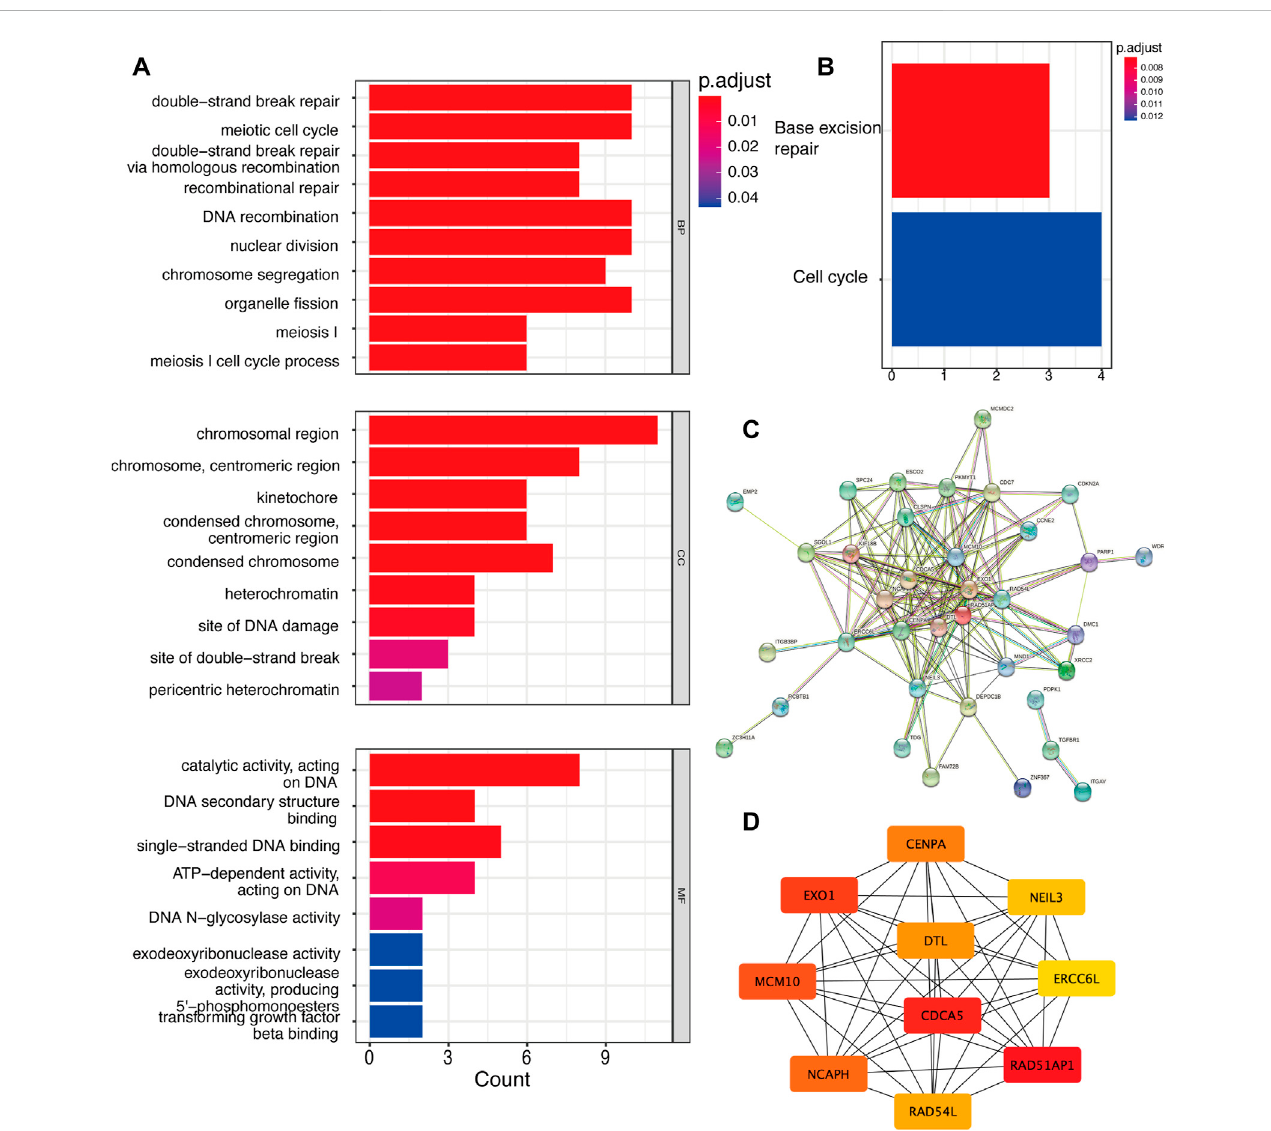
FIGURE 2 The down-regulated DEGs regulatory network and gene functions. (A) . GO analysis of down-regulated DEGs. (B) . KEGG analysis of DEGs. (C) . The PPI network of DEGs. (D) . Top 10 hub genes of down-regulated genes. DEG: differentially expressed genes, PPI: protein-protein interaction.